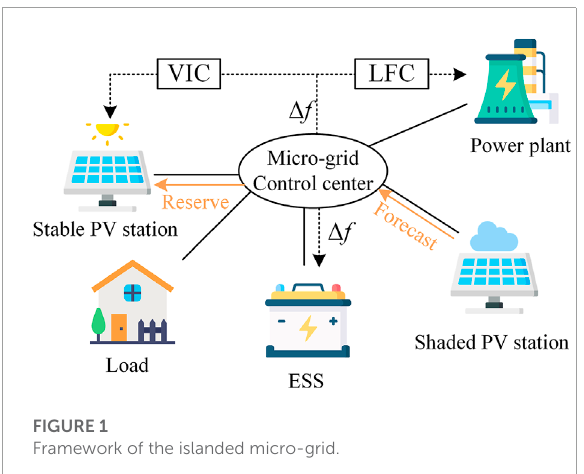
FIGURE 1 Framework of the islanded